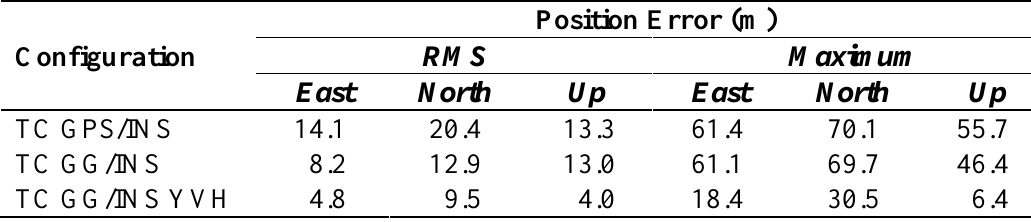
Table 6. Position error obtained with TC